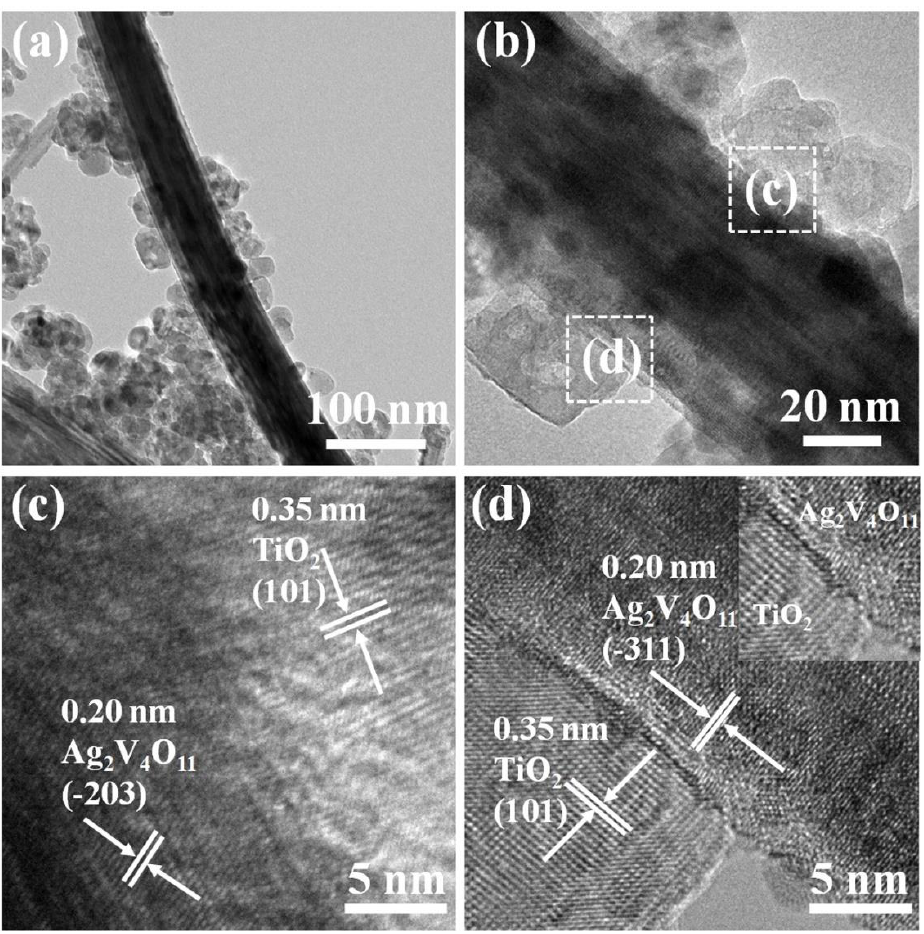
Figure 5. ( a , b ) TEM and ( c , d ) HRTEM images of TA2 sample.